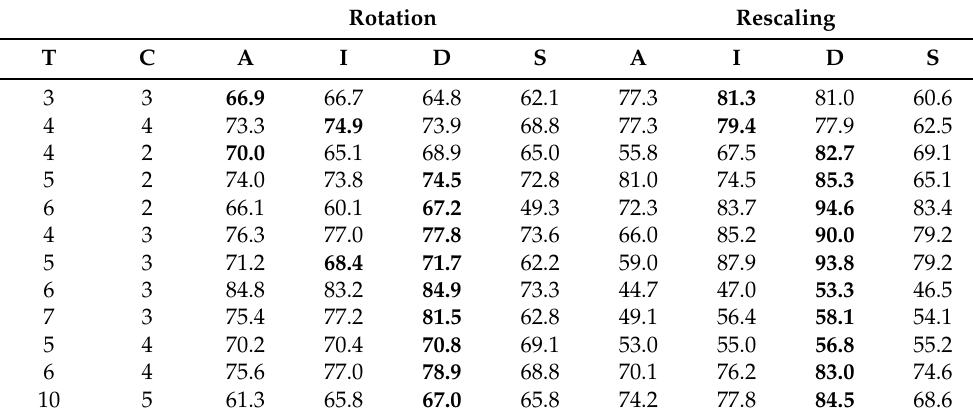
Table 2. Results of Experiment 2 for the rotation and rescaling cases. “T” is the number of target labels and “C” is the number of target labels common to the source. “A” is the performance of ADDA [9], “I” is the performance of IWPDA [8], “D” is the performance of DIWAN, and “S” is the performance of the source model without adaptation. The results are the average accuracy percentages over 10 trials. Best accuracy indicated in